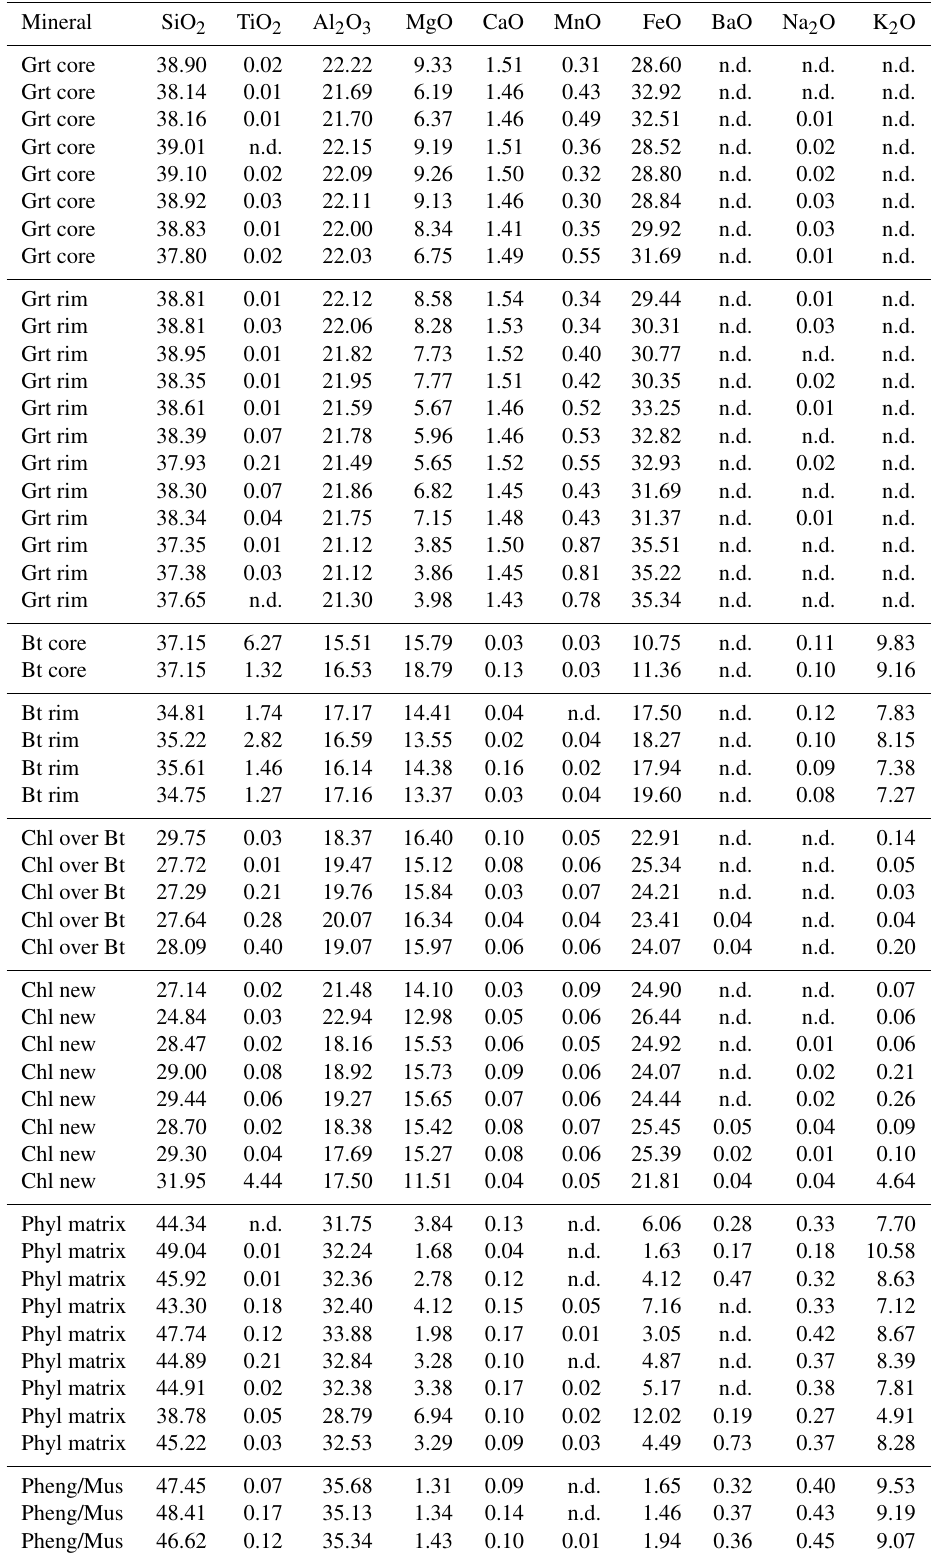
Table 1. Results of the microprobe analyses of the rock-forming silicates; n.d.: not detected. Grt: garnet, Bt: biotite, Chl: chlorite, Phyl: phyllosilicate(s), Pheng: phengite, and Mus: